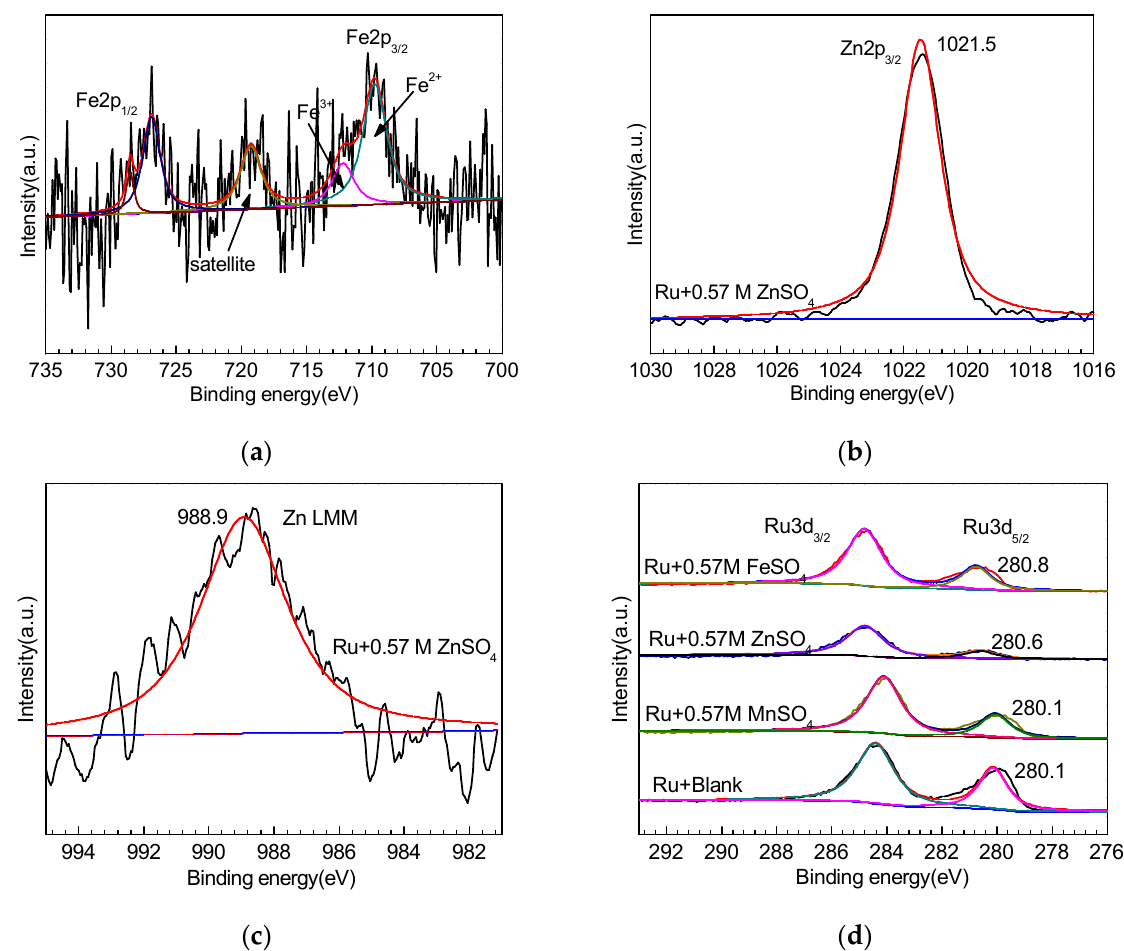
Figure 3. XPS profiles of the monometallic Ru catalyst after hydrogenation reaction applying 0.57 mol L − 1 of ZnSO 4 , FeSO 4, and MnSO 4 as the reaction modifiers. ( a ) Fe 2p over the monometallic Ru catalyst applying 0.57 mol L − 1 FeSO 4 ; ( b ) Zn 2p 3/2 over the monometallic Ru catalyst applying 0.57 mol L − 1 ZnSO 4 ; ( c ) Zn LMM over the monometallic Ru catalyst applying 0.57 mol L − 1 ZnSO 4; and ( d ) Ru 3d applying 0.57 mol L − 1 of ZnSO 4 , FeSO 4 , and MnSO 4 as the reaction modifiers.